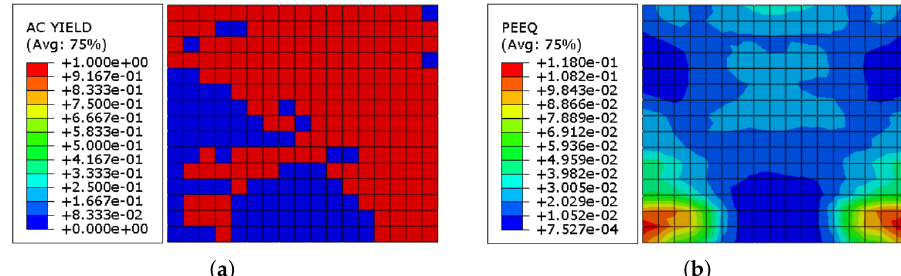
Figure 22. ( a ) AC yield distribution in the URM; ( b ) equivalent plastic strain (˜ ε pl c ) distribution in the URM.